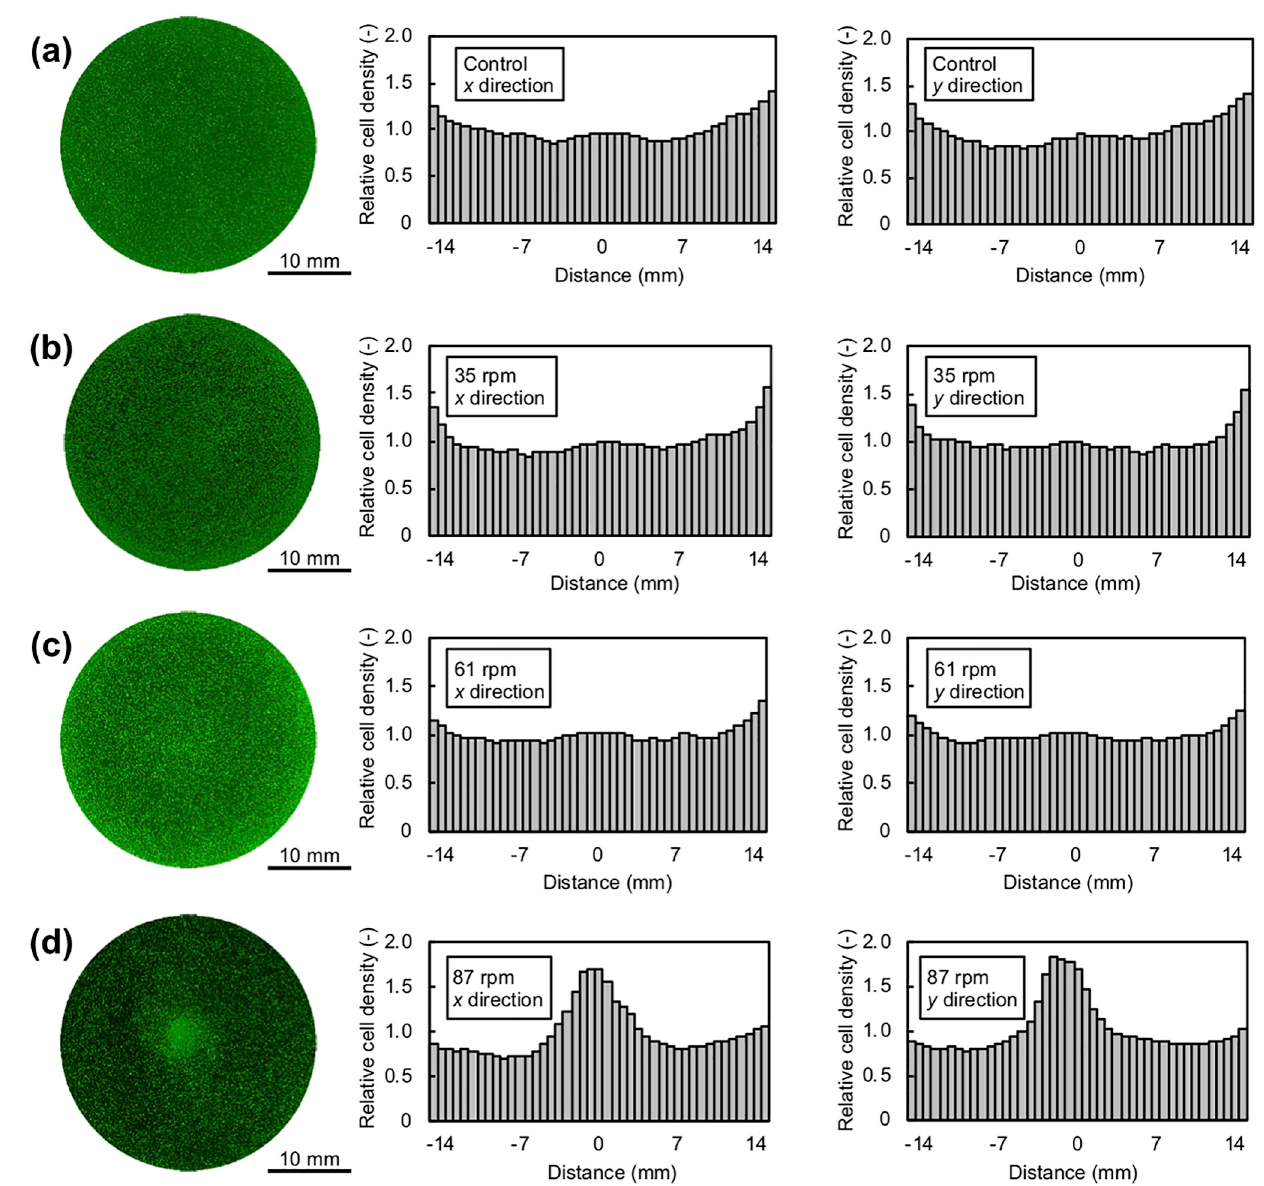
Fig 4. Fluorescence microscopy images of culture dishes and relationship between relative cell densities along the x and y directions ( n = 3). (a-d) Cells were seeded in culture dishes without shaking (a) or with shaking at 35 rpm (b), 61 rpm (c), or 87 rpm (d) for 3 min. The green fluorescence shows viable